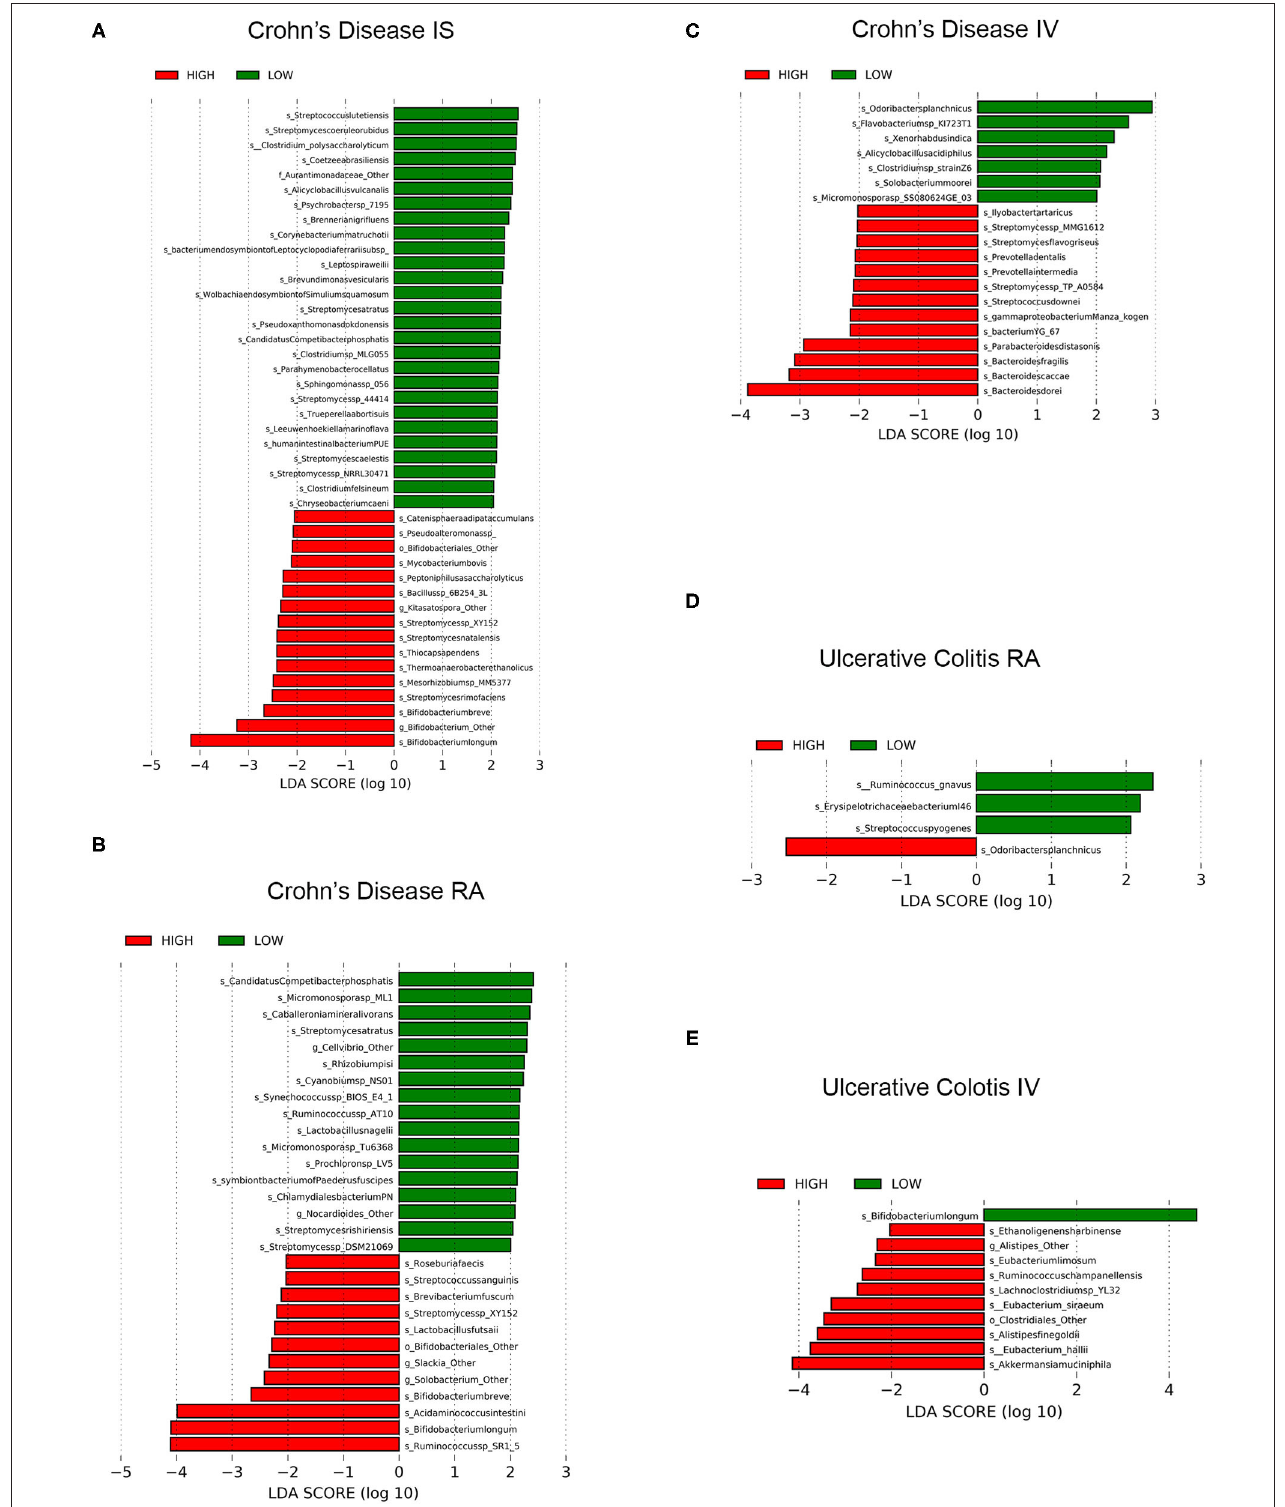
FIGURE 3 | LEfSe analyses of significant fecal microbiomes of Patients with IBD and circadian wrist actigraphy alignments. LEfSe identifies bacterial (species) clades that are differentially abundant within IBD classification types [Crohn’s disease (CD) or Ulcerative Colitis (UC)] circadian wrist actigraphy class and alignments subclass. (A) CD Interdaily Stability (IS) Low and High (B) CD Relative Amplitude (RA) Low and High; (C) CD Intradaily Variability (IV) Low and High; (D) UC RA; Low and High; and (E) UC IV Low and High. Clade colors: Low alignments (green) and High alignments (red). Clades in these graphs were both statistically significantly ( P < 0.05) and exceeded an LDA log score of at least ( ±